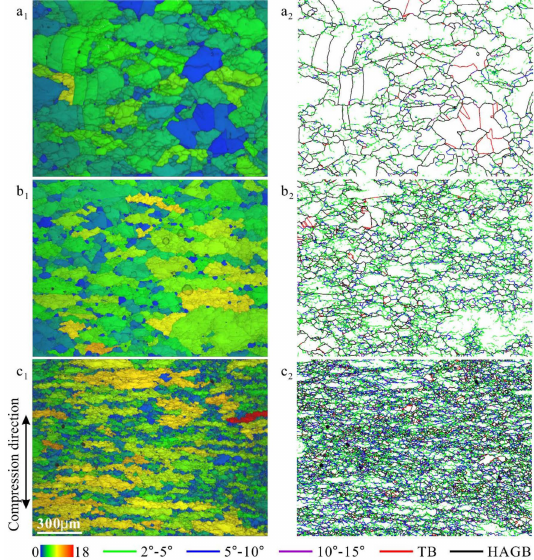
Figure 3. Microstructures of 18Mn18Cr0.6N steel compressed at 10 − 4 s − 1 and a cooling rate 0.025 Ks − 1 to different strains: 0.2 ( a 1 , a 2 ), 0.4 ( b 1 , b 2 ), and 0.8 ( c 1 , c 2 ). ( a 1 ), ( b 1 ), and ( c 1 ) are band contrast images overlaid by grain orientation spread images; ( a 2 ), ( b 2 ), and ( c 2 ) are grain boundary characteristic distribution images. The vertical direction is the compression